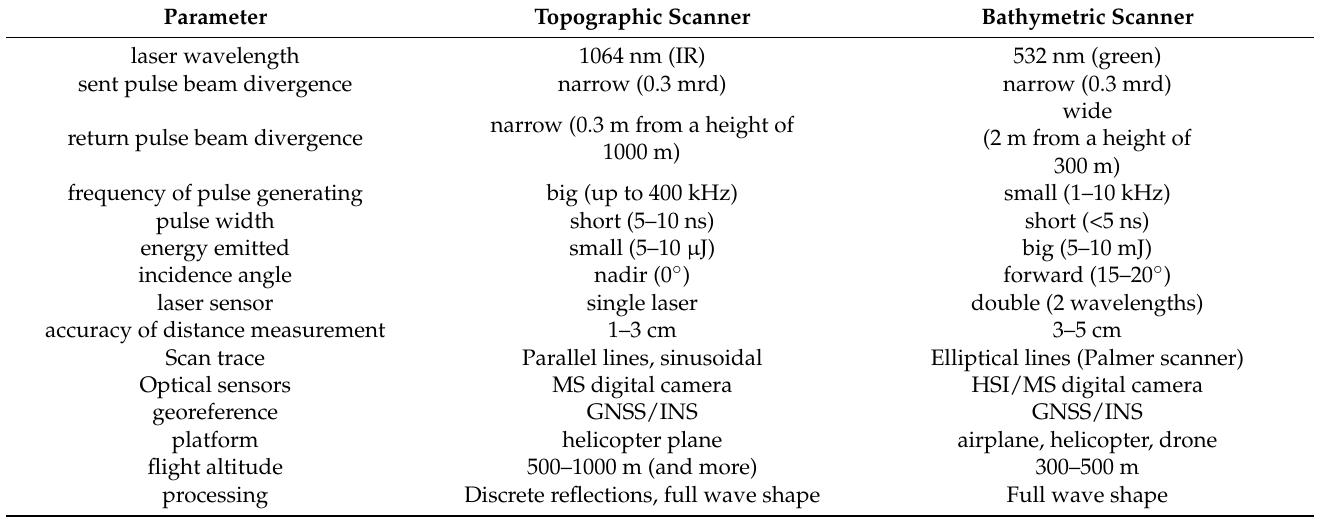
Table 2. Comparison of typical parameters of topographic and bathymetric